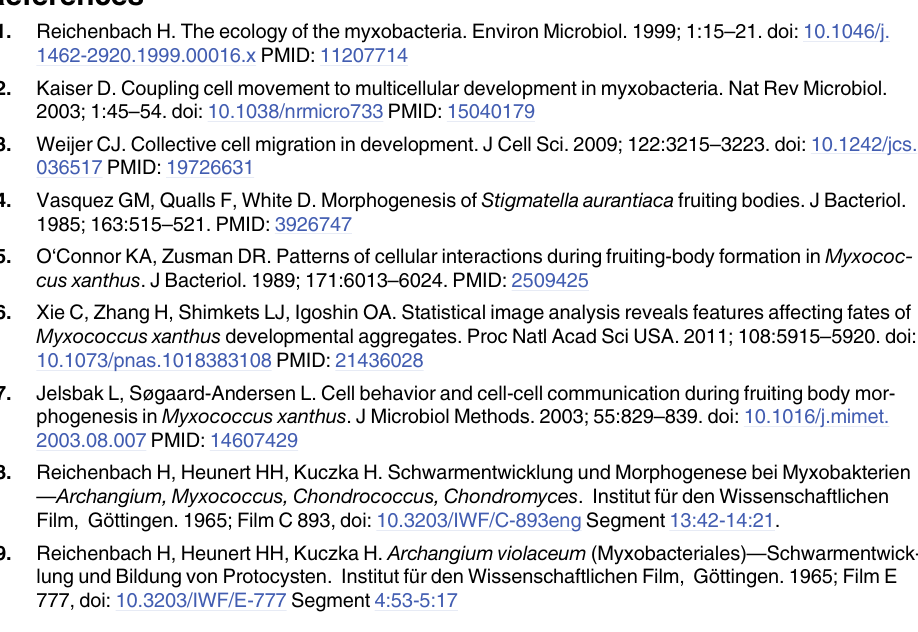
S13 Video. Cell movement patterns in a high-density population of flexible cells with active following. Color indicates speed of individual cells (colorbar at the bottom, μ m (cid:2) min − 1 ). (AVI) S14 Video. Cell movement patterns in a high-density population of very rigid cells with ac- tive following. Color indicates speed of individual cells (colorbar at the bottom, μ m (cid:2) min − 1 ). (AVI) S15 Video. Cell movement patterns in a low-density population of flexible, reversing cells with active following and reversal suppression. Color indicates speed of individual cells (col- orbar at the bottom, μ m (cid:2) min − 1 ). (AVI) S16 Video. Cell movement patterns in a low-density population of long-range guided rigid cells. Color indicates speed of individual cells (colorbar at the bottom, μ m (cid:2) min − 1 ). (AVI) S17 Video. Cell movement patterns in a low-density population of long-range guided flexi- ble cells. Color indicates speed of individual cells (colorbar at the bottom, μ m (cid:2) min − 1 ).